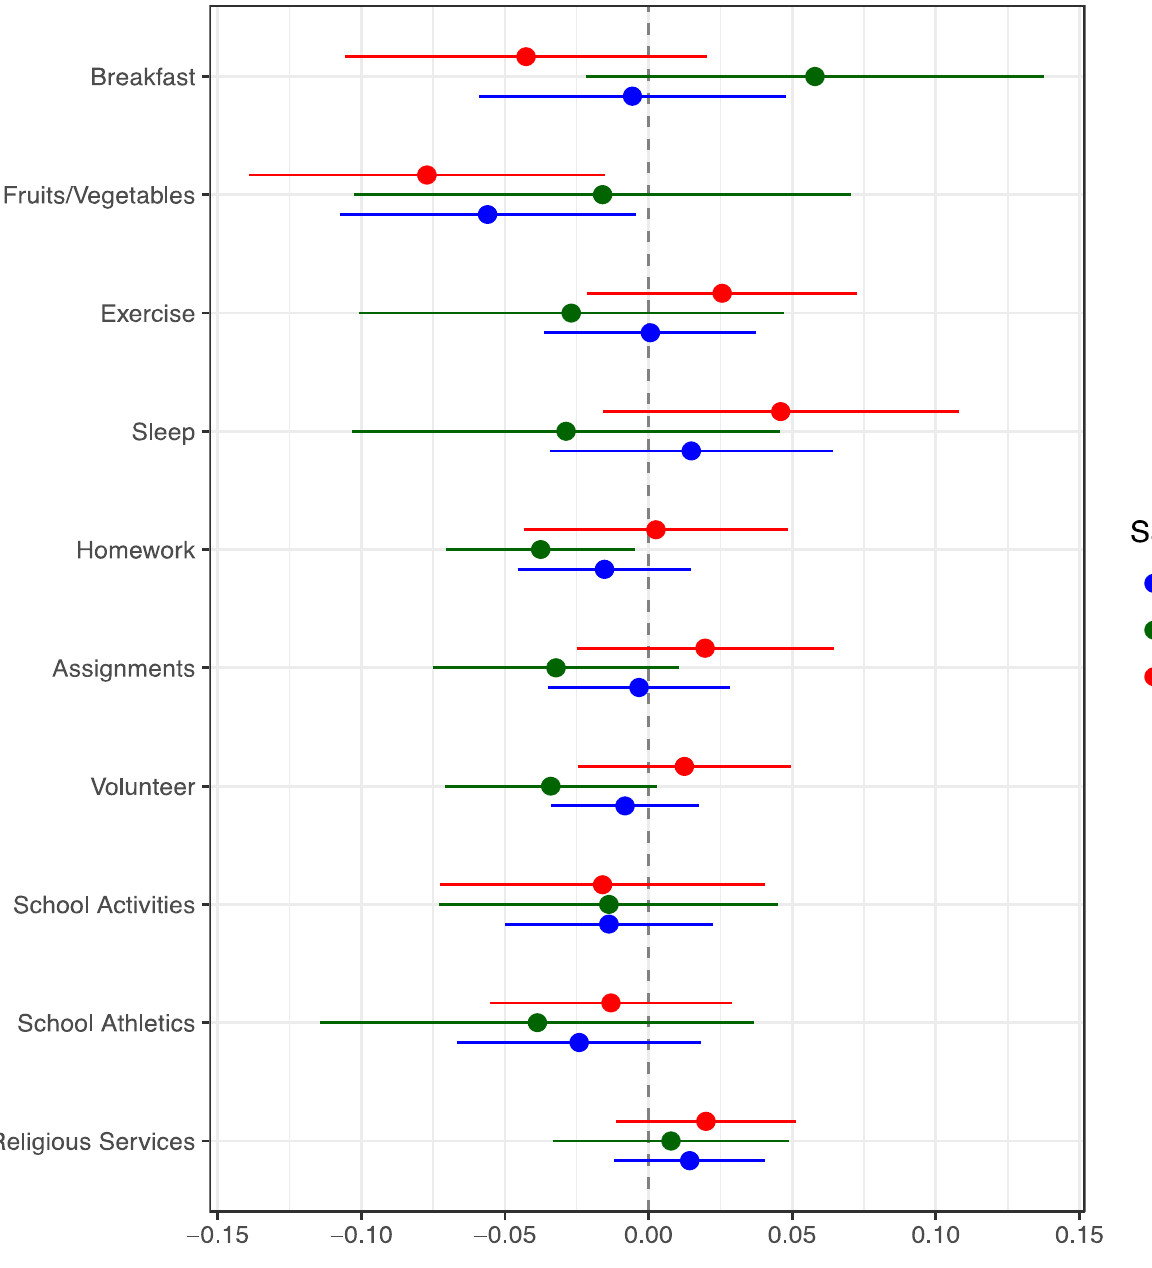
Figure 1. Ordinary Least Squares Difference-in-Differences (DD) Estimates of the Effects of Welfare Reform on Positive Adolescent Health and Social Behaviors, United States. Notes: The sample con- sisted of 10th and 12th graders (<age 18 years) whose mothers had a high school education or less and were unmarried. DD coefficients of the welfare reform indicator (Welfare, from Equation (A1) in the Appendix A) are shown, with 95% confidence intervals. The models controlled for the characteristics listed in Table 1, state/year covariates (unemployment rate, poverty rate, personal income per capita, Earned Income Tax Credit (EITC) rate, refundable EITC, minimum wage, # Medicaid beneficiaries, #s of National School Lunch and School Breakfast Program participants, and population), lagged economic/welfare conditions (one, two, and three-year lags of the unemployment rate, poverty rate, state personal income per capita, and welfare caseloads) and indicators for state, year and month. Sample sizes ranged from 7358–24,272 (pooled genders), 2992–9704 (boys), and 4366–14,658